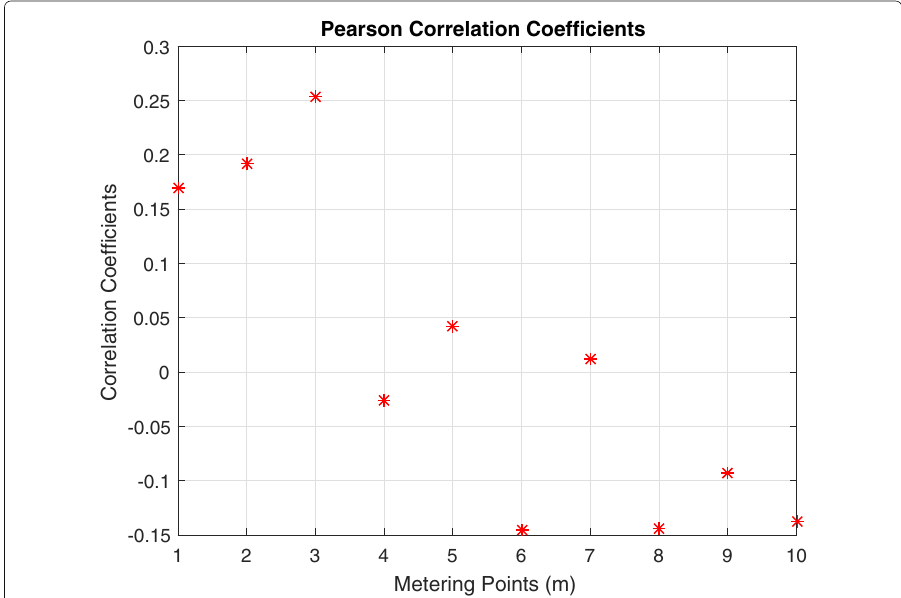
Fig. 3 Pearson correlation coefficients for all the metering points in a 5-bus power network